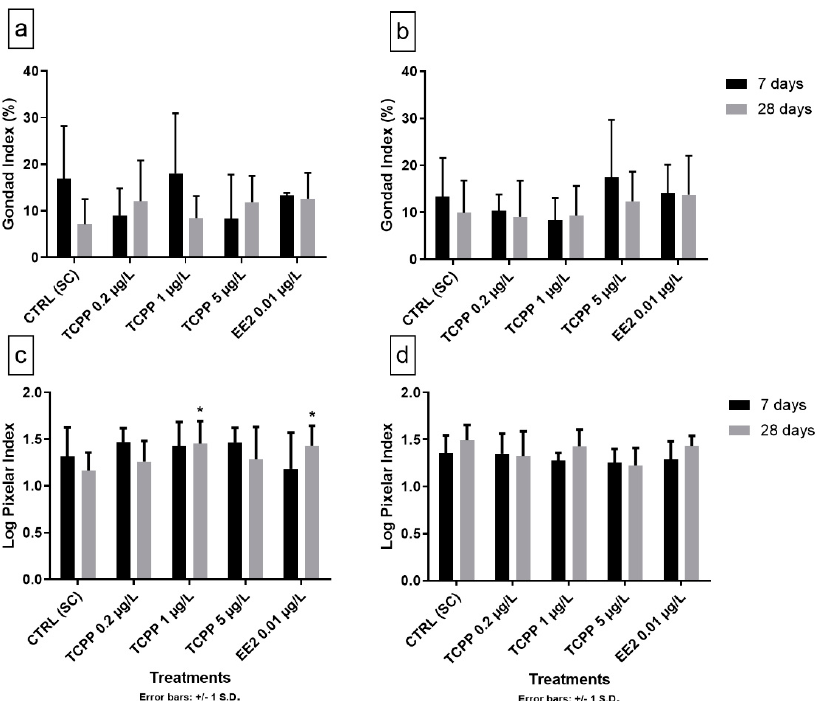
Figure 4. Gonad Index ( a , b ) and Pixelar Index ( c , d ) (mean ± SD) of female ( a , c ) and male ( b , d ). P. lividus sea urchins exposed for 7-d (black bars) and 28-d (grey bars) to TCPP in 2017 (n = 4–14). Asterisks indicate significant ( P < 0.05) differences with respect to solvent control (CTRL (SC)). The Pixelar Index is a quantitative and objective tool used for the assessment of the stage of development in male and female gonads [49]. In 2016, females exposed to 10 µg/L TCPP showed significant higher values than control regardless of exposure time ( P = 0.039 on day 7 and P = 0.006 on day 28). Significant differences were also observed in males, with an increase in PI values at a concentration of 1µg/L ( P = 0.030) on day 7, and at a concentration of 10 µg/L ( P = 0.041) at day 28 compared to solvent controls. However, in the case of males, significantly decreased PI values were also observed in the solvent controls compared to seawater controls ( P = 0.002), and no significant differences were found between TCPP treatments and seawater controls. In 2017, PI values in females were significantly higher than solvent controls for the 1 µg/L TCPP and the 10 ng/L EE2 treatments after 28-d exposure ( P = 0.015 and P = 0.025, respectively), whilst no significant effects were observed in males at any treatment. The high inter-individual variability in gonad development may hinder statistical detection of differences among treatments. Future experimental designs can be improved by increasing sample size and taking several gonad samples from the same individual. 3.4. Natural and Anthropogenic Factors Affecting the Reproductive Cycle The gametogenic cycle of P. lividus populations was described in Ireland [48], France [50], and in the Mediterranean [51,52] and Atlantic [53–56] coasts of Spain. The main exogenous factors that seem to control the reproductive cycle are temperature, photo-period and food availability, but as to the endogenous mechanisms that control gametogenesis, the role played by steroid hormones and the possible estrogenic effects of synthetic xenobiotics in echinoderms are actually poorly understood. The role of estrogens in the control of gametogenesis in invertebrates is under debate, and while some findings support the induction of gametogenesis mediated by oestrogen receptors